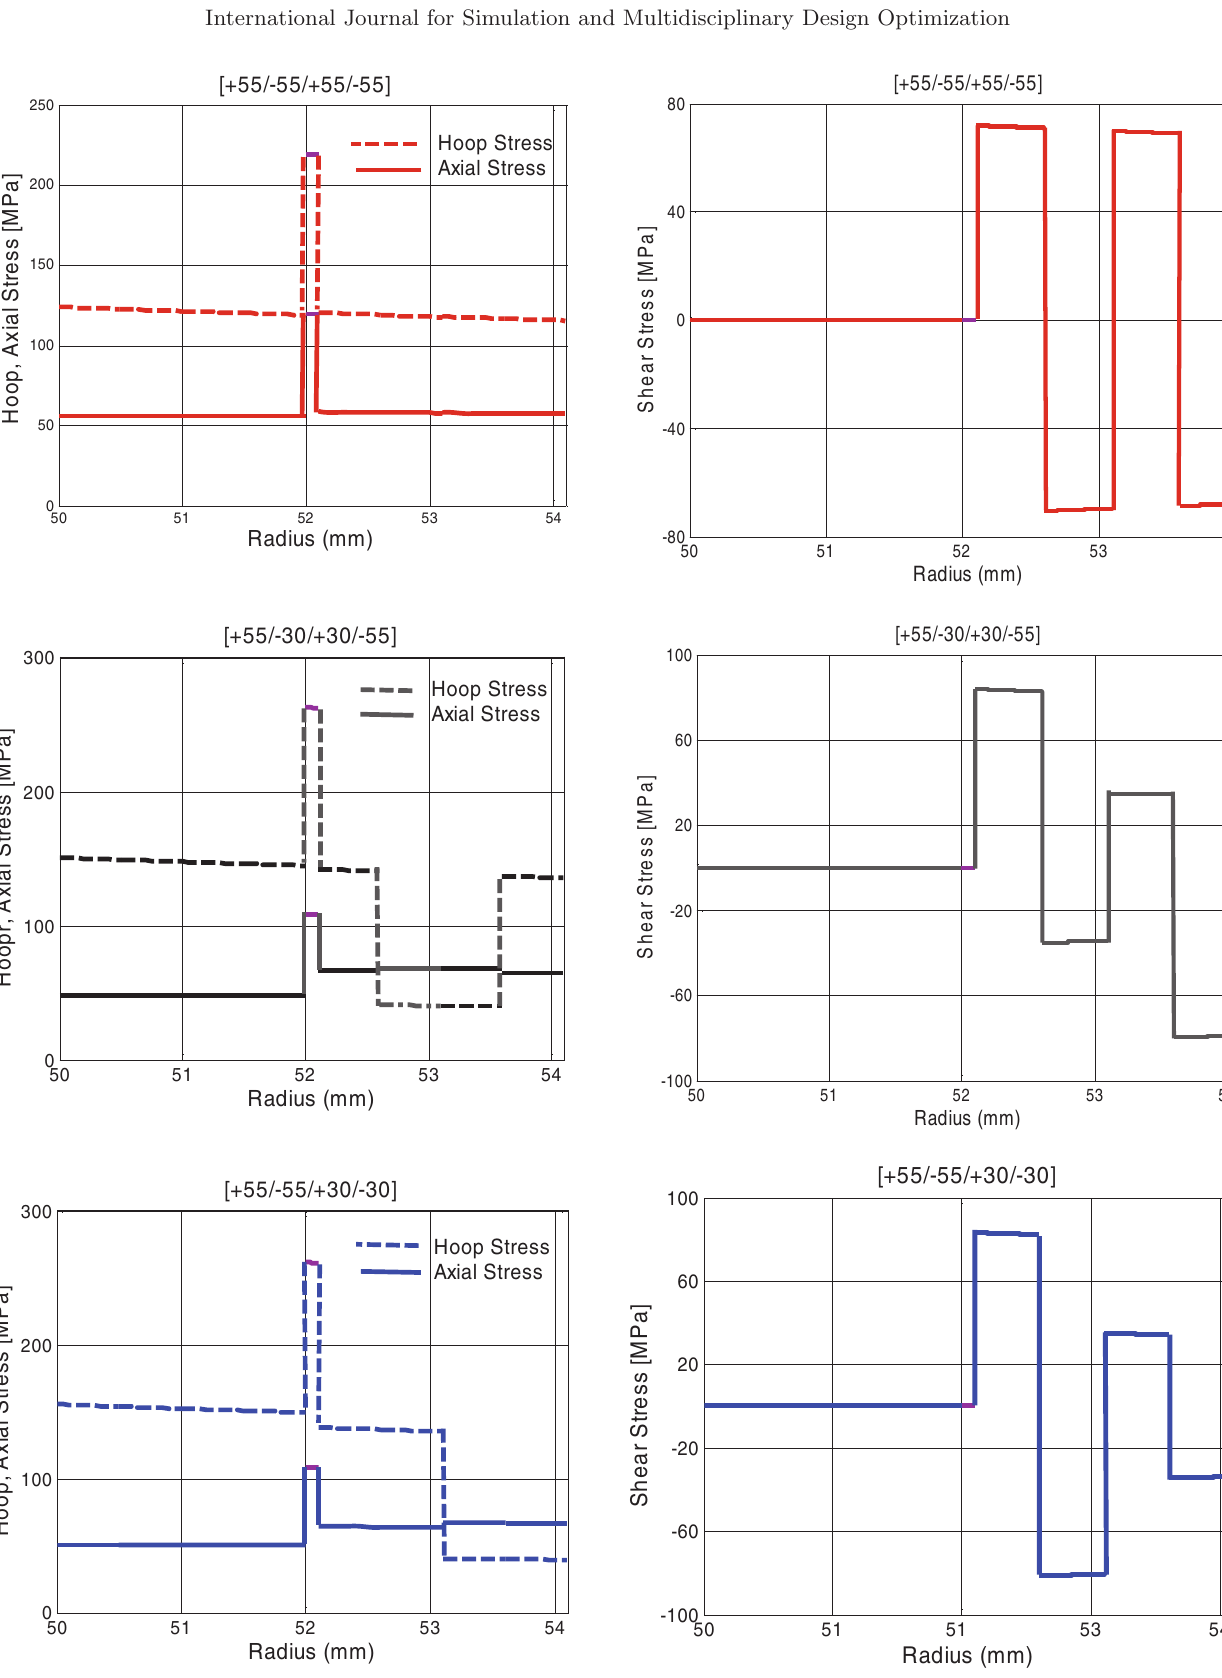
Fig. 3. The distribution of shear stress through the